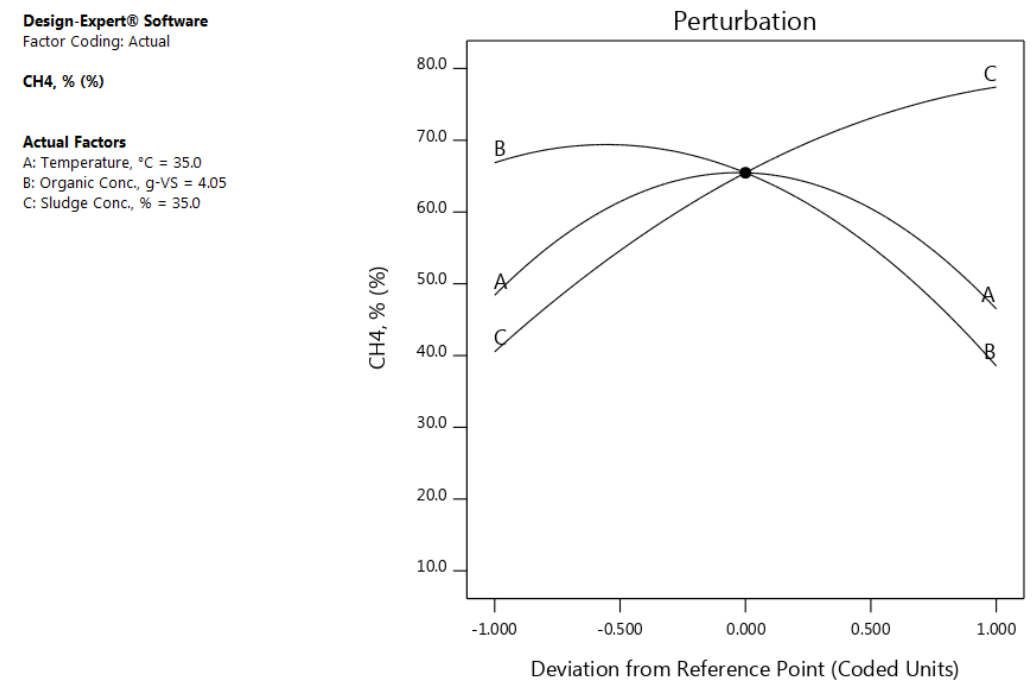
Figure 7. The Perturbation plot of the CH 4 % response.